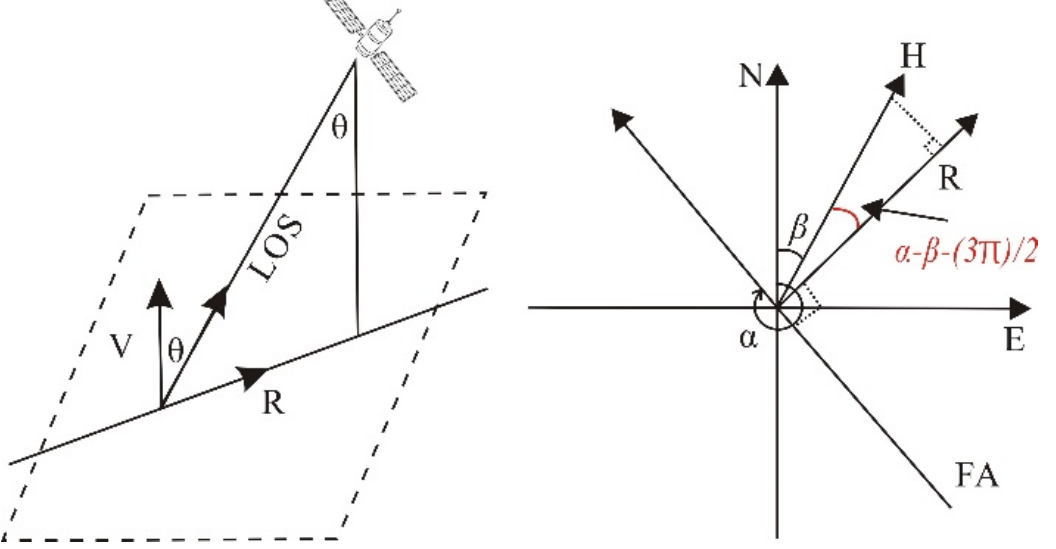
Figure 5. Schematic diagram of the projection of the radar flight direction and the surface movement direction; V is the vertical projection direction, R is the range direction, H is the slope sliding direction, and FA is the radar flight direction (modified after [36]).